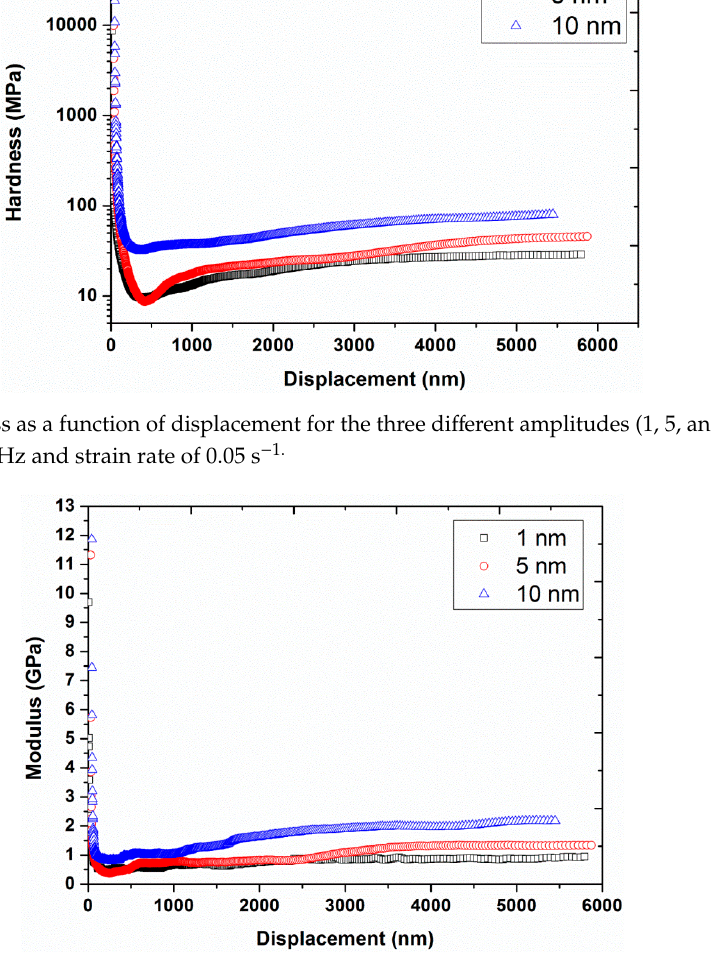
Figure 3. Modulus as a function of displacement for the three different amplitudes (1, 5, and 10 nm) at a frequency of 45 Hz and strain rate of 0.05 s − 1.